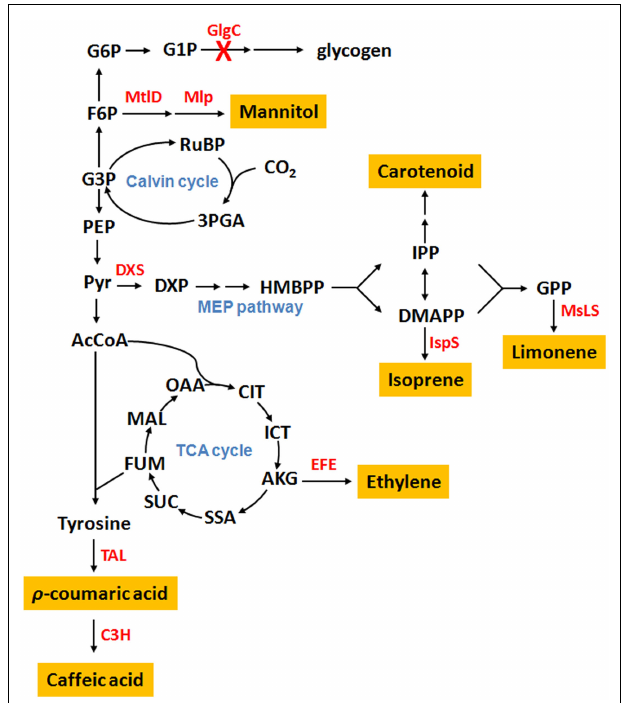
FIGURE 1 | Cyanobacterial metabolic pathways for the production of plant secondary metabolites . Abbreviation: G6P, glucose-6-phosphate; G1P, glucose-1-phosphate; F6P, fructose-6-phosphate; G3P, glyceraldehyde-3-phosphate; RuBP, ribulose-1,5-diphosphate;